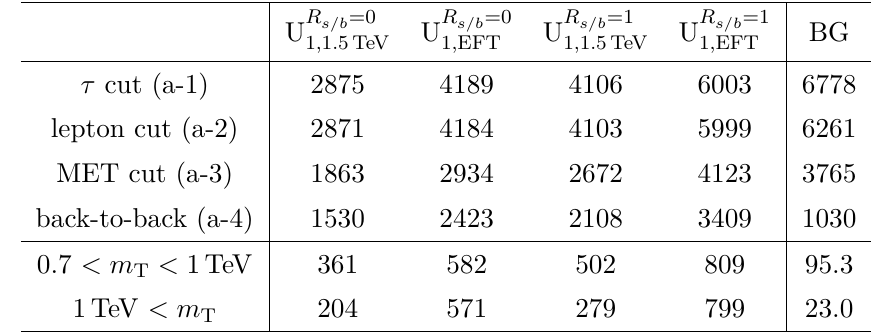
Table 12 . Same as table 11 but for the U 1 LQ scenario with the U(2) flavor symmetry, where R L dt C V = 1 and = 35 . 9 fb − 1 1